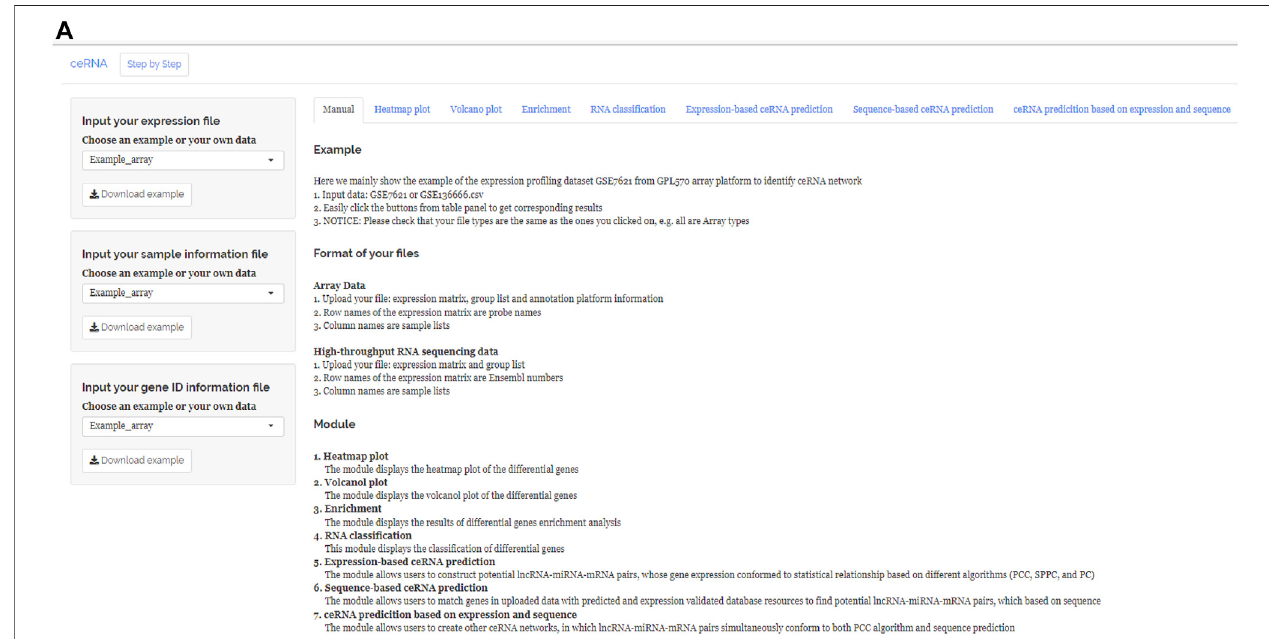
FIGURE 1 | Main interface of ceRNAshiny. (A) The main interface of ceRNAshiny for introduction and analysis.